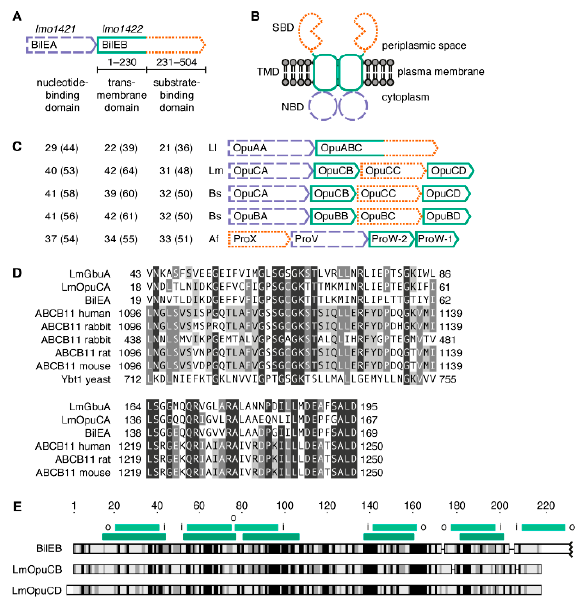
Figure 1. ( A ) The genetic arrangement of BilE; ( B ) a schematic of the predicted functional transporter; and ( C ) comparison to characterized homologs. Strain details and protein accession numbers are listed in Table A1. Genes and proteins are color-coded based on the predicted function: nucleotide-binding domains (NBDs), purple long dashes; transmembrane domains (TMDs), solid green; substrate-binding domains (SBDs), orange short dashes. When two TMDs are present, values from the closest match are reported. Numbers indicate the percentage sequence identity (similarity) between equivalent domains based on pairwise alignments made with the program needle from EMBOSS (the European Molecular Biology Open Software Suite) [34]. ( D ) An extract from a multiple sequence alignment of selected NBDs. The region shown is the same as in Sleator et al. [18], but the alignment has been expanded to include proteins from the Listeria monocytogenes Gbu and OpuC systems. Residues are shaded according to percentage sequence identity. ( E ) Multiple sequence alignment of BilEB and the TMDs from Listeria monocytogenes OpuC. Numbering is according to BilEB. Sequences are shaded according to percentage sequence similarity. Bars above the alignment indicate transmembrane segments (TMSs) predicted by TOPCONS [35] (light green) or by comparison to crystal structures of homologous ABC importers (dark green). Lettering indicates the orientation of predicted TMSs relative to the cytoplasm (out-to-in or in-to-out), which is in agreement between the two